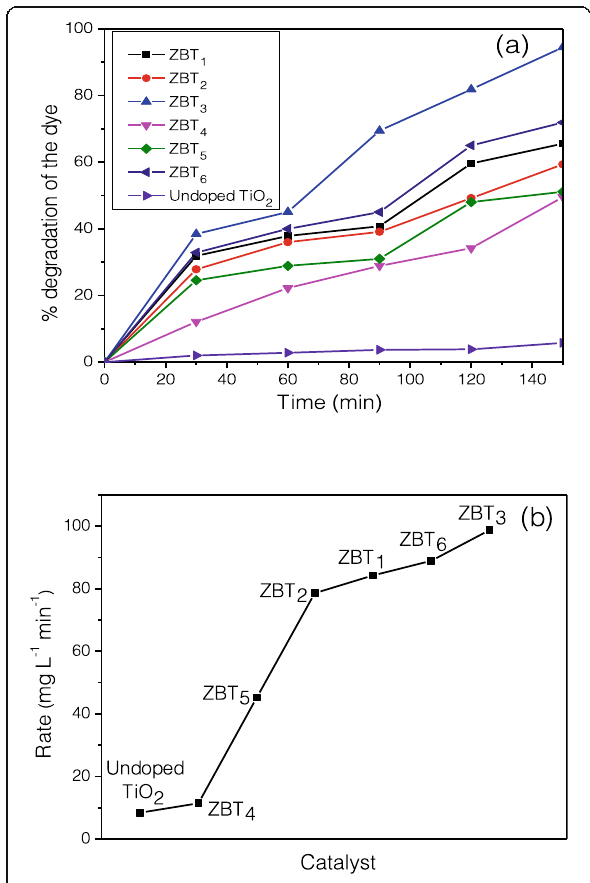
Fig. 8 ( a ) Dopant concentration on photocatalytic activity of co-doped titania by % degradation of AR 6A at catalyst dosage 50mgL − 1 , pH6 and